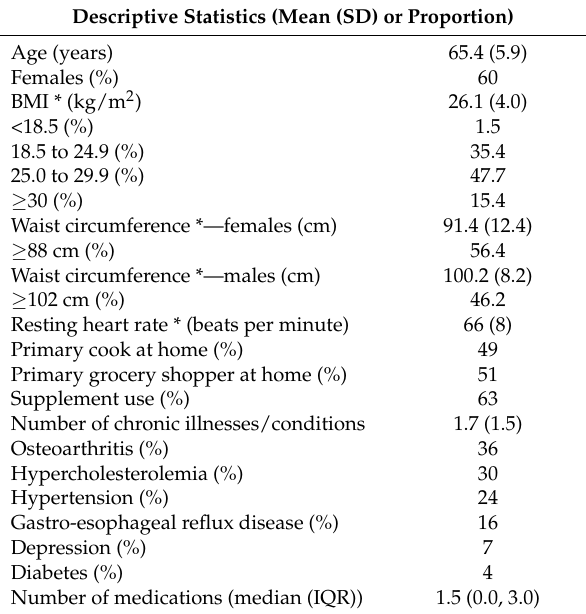
Table 1. Participant characteristics at baseline ( n = 84).